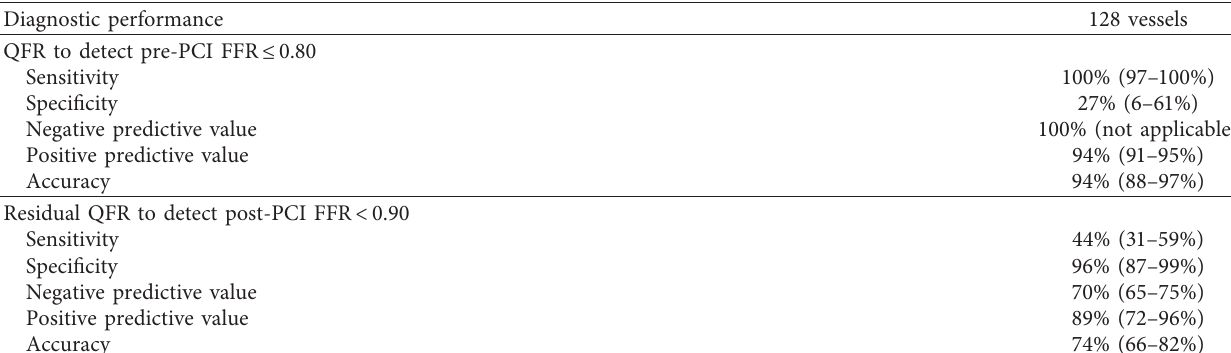
Figure 3: Correlation and agreement between QFR and pre-PCI FFR and residual QFR and post-PCI FFR. Scatterplots with corresponding correlation coefficients and Bland–Altman plots with ICCs demonstrating the correlation and level of agreement between QFR and pre-PCI FFR and residual QFR and post-PCI FFR. FFR, fractional flow reserve; PCI, percutaneous coronary intervention; QFR, quantitative flow ratio; CI, confidence interval; ICC, intraclass correlation coefficient; SD, standard deviation. Table 5: Diagnostic performance of QFR and residual QFR to assess significant CAD (pre-PCI FFR ≤ 0.80) and a suboptimal PCI outcome (post-PCI FFR < 0.90),